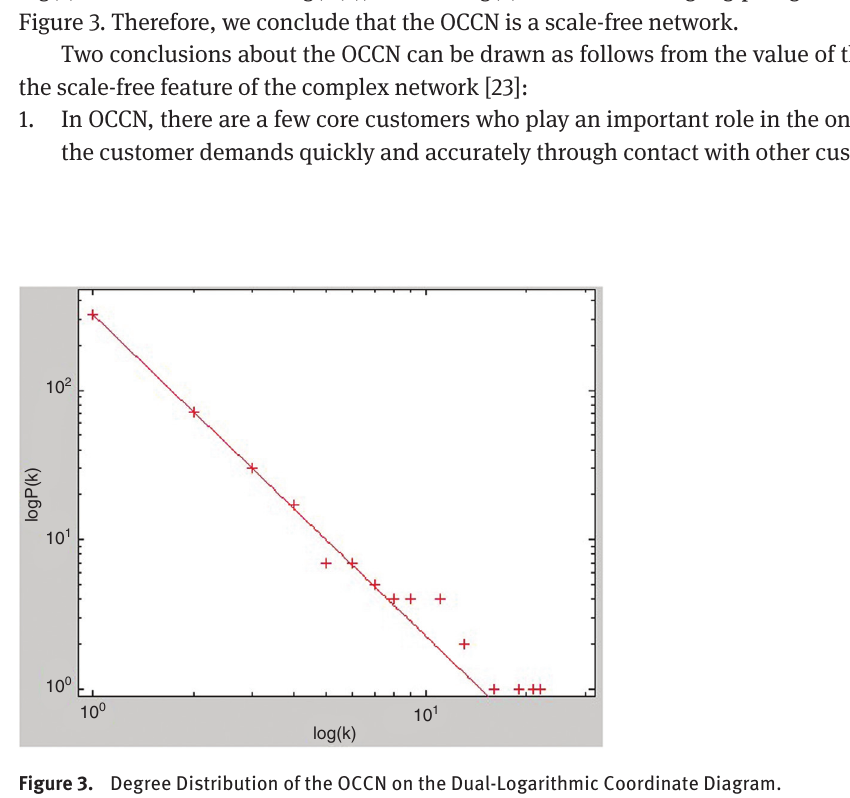
Figure 3. Degree Distribution of the OCCN on the Dual-Logarithmic Coordinate